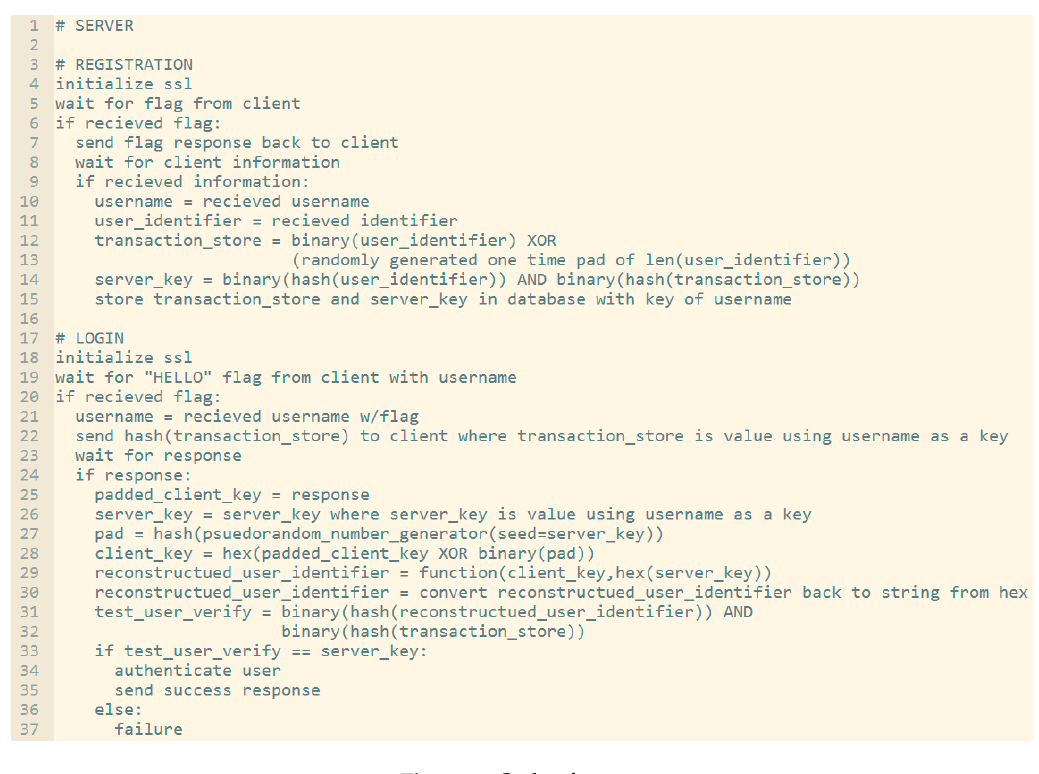
Table 2. Time complexities.